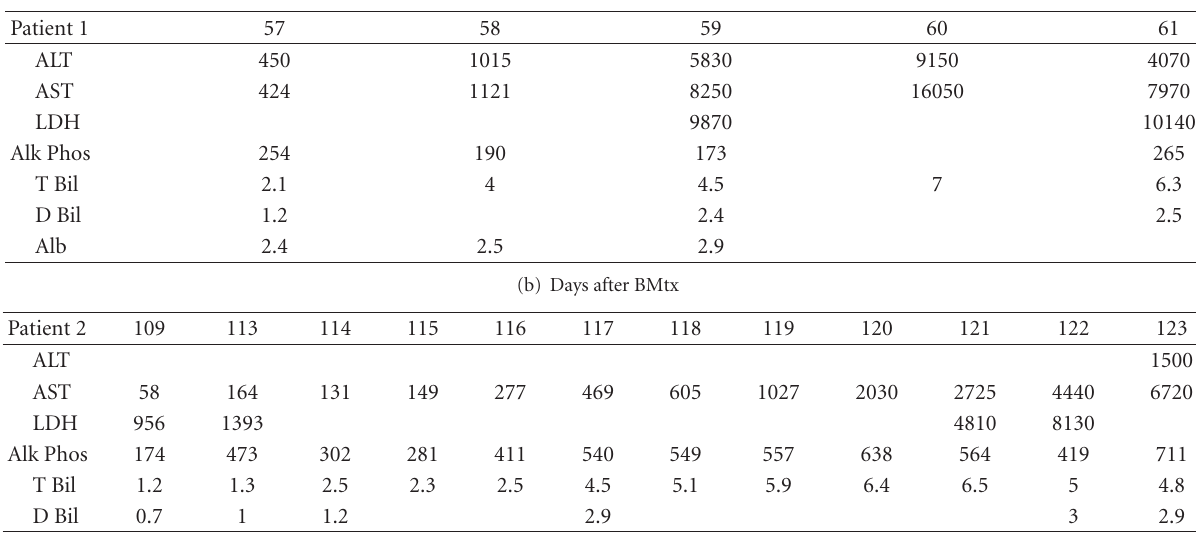
Table 1: Values of liver function tests for Patients 1 and